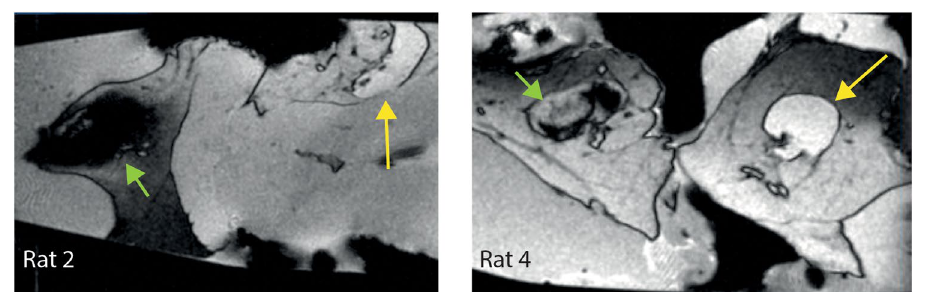
Figure 4. MR images of the excised tissues containing the sentinel lymph node (green shortshafted arrow) and control node (yellow long-shafted arrow) for animal 2 (detectable with MMUS) and animal 4 (not detectable with MMUS). Both lymph node samples (together with some of their surrounding tissue) were placed in an Eppendorf tube during the MRI acquisition. The superparamagnetic nanoparticles present in the sentinel lymph node are shown as hypoenhanced voids (black). The black areas around and in between the two tissue samples stem from air pockets. A considerably larger hypoenhancement can be seen for animal 2 compared to animal